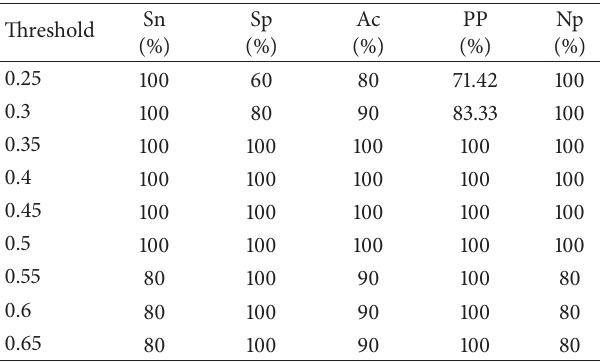
Table 4: Evaluation metrics of the gene F56F11.4